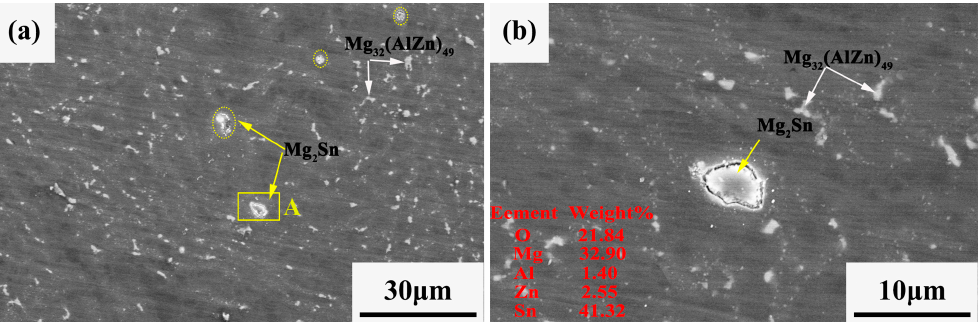
Figure 8. ( a ) Initiation corrosion sites of ZAT543 alloy immersed in 3.5 wt % NaCl for 10 min; ( b ) high-magnification morphology of region A.